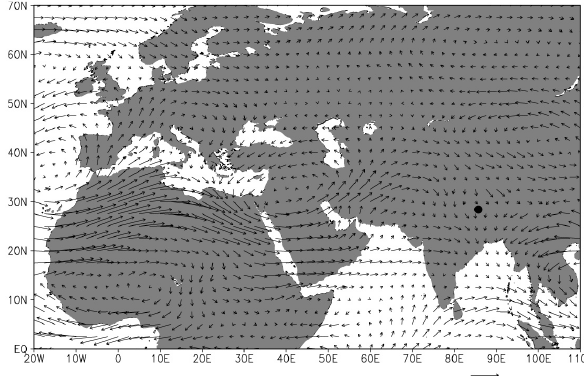
Fig. 5. Composite analysis of moisture flux (multiplying by wind vector and specific humidity) at 400hPa level during the winter– spring season (February to April) between years with higher and lower Dasuopu accumulation rate (higher minus lower). The filled black circle indicates the DSP core drilling